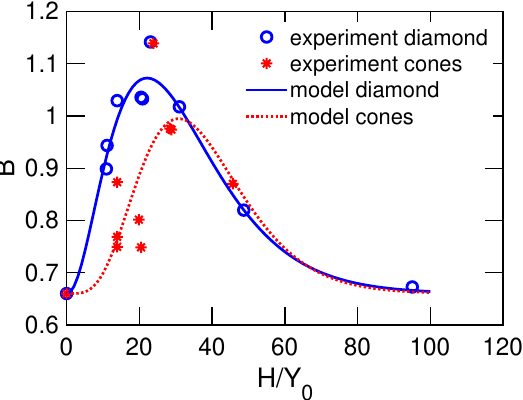
Figure 9. Comparison between experimental and modeled (Equation (14)) values of B for the tested cones and diamonds [46] micro-protruded heat